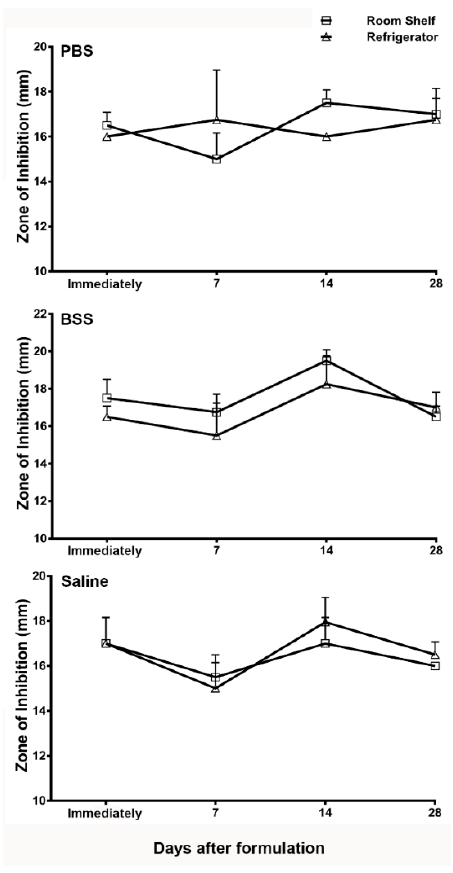
Figure 2. Zone of inhibition (in mm) of the PBS, BSS, and normal saline vancomycin formulations analyzed by a microbiology assay immediately after formulation and then at days 7, 14, and 28 after storage at room temperature or under refrigeration. The data is presented as mean ± standard error of mean (SEM).